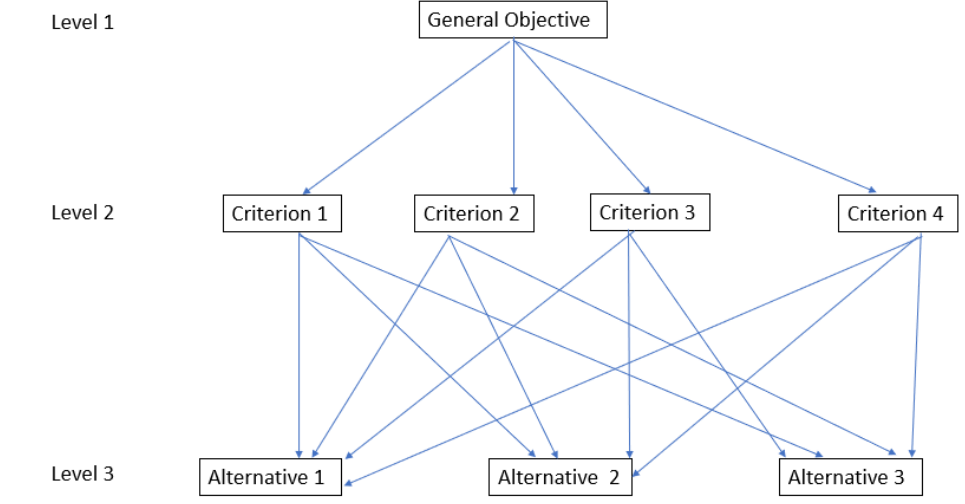
Figure 4.1 The Digraph of the Functional